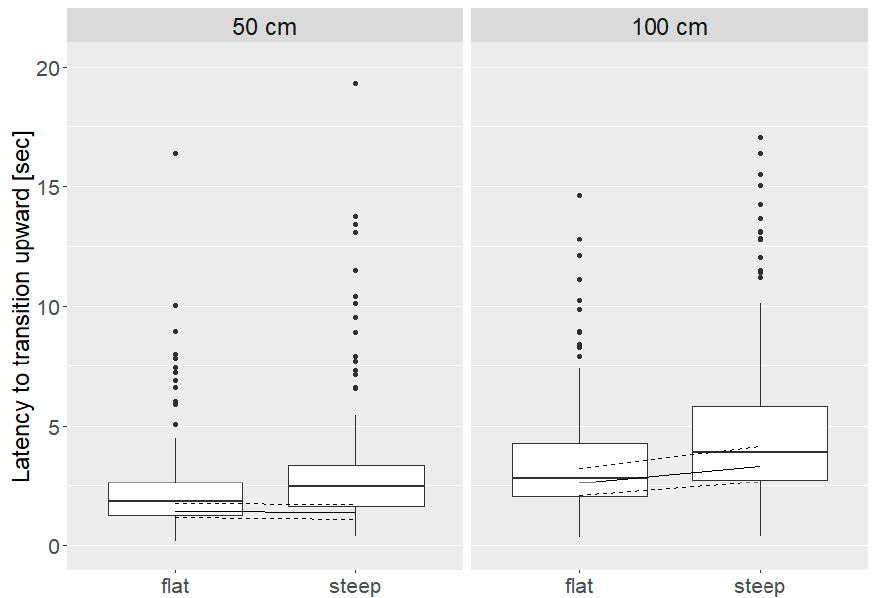
Figure 5. Latency to transition (sec) for distances of 50 cm and 100 cm and flat and steep angles (distance * angle: p = 0.048). Boxes show medians, lower and upper interquartile range. Whiskers indicate 1.5 times the interquartile range. In addition, model estimates with estimated means (solid line) and 95% confidence intervals (dashed lines) are shown.